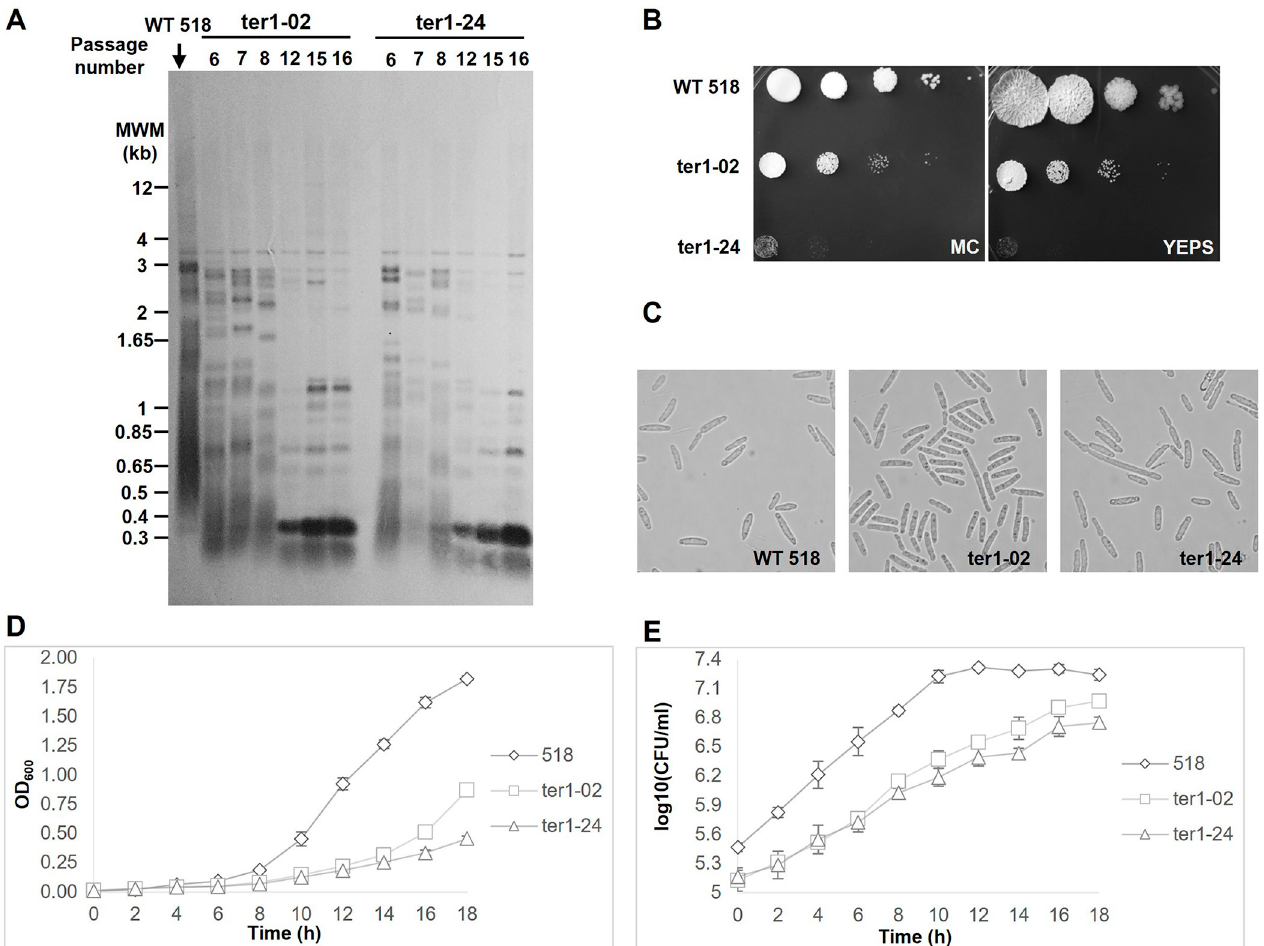
Fig 5. Phenotypic alterations caused by the interruption of ter1 in U . maydis . (A) TRF analysis of the WT 518 strain and ter1 mutants. The loss of TER triggers a progressive shortening of TRF and eventually leads to the emergence of surviving cells showing the amplification of a 350 bp fragment. (B) Serial 10-fold dilutions of cultures were spotted on YEPS or MC plates and incubated for 2 days at 28˚C; ter1 mutants showed dramatic decreases in colony formation and colony size, consistent with the loss of telomerase activity described in other organisms. (C) Cell morphology of strain WT 518 and mutants ter1-02 and ter1-24. The interruption of ter1 causes alterations in cell morphology, and the mutants have irregularly edged cells and an increase in the presence of elongated cells with alterations in the budding angle, suggesting defects in cell cycle regulation. (D and E) Growth kinetics of the WT strain and ter1 mutants. Strains were grown in YEPS broth (28˚C) and sampled every two hours. Samples were used for measurements of OD 600 or were diluted and plated. Colonies were counted after 24 h of incubation at 28˚C and plotted. The results of triplicate assays are shown.